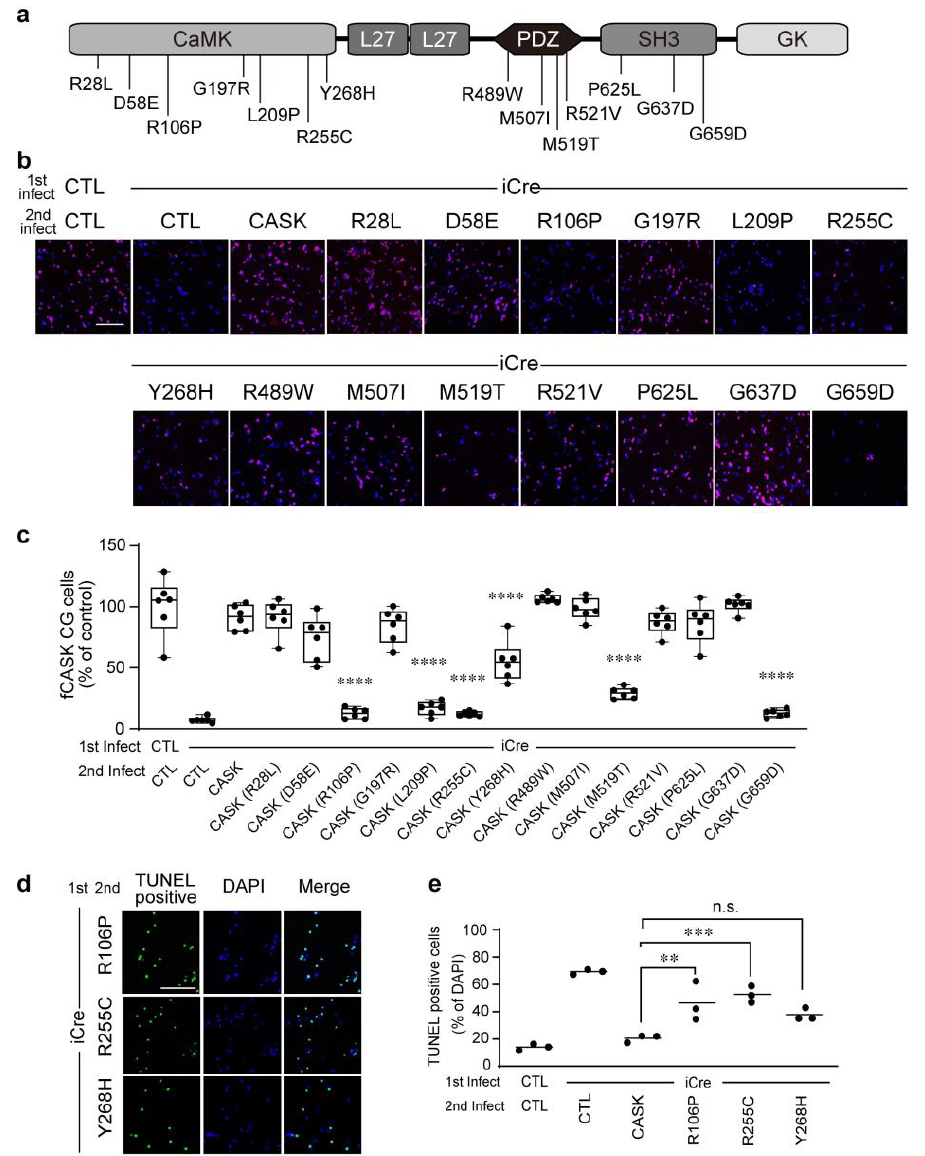
Figure 5. CASK missense mutations from human patients affect the survival of cultured CG cells. ( a ) Schematic diagram of CASK missense mutations identified from human patients. ( b ) Effects of CASK missense mutants on CASK KO CG cell survival. Cultured CG cells are infected with lentivirus-iCre (iCre) together with lentivirus-CASK (WT or mutants). Cells were stained with the antibody against NeuN (red) and DAPI (blue). Scale bars = 100 µ m. ( c ) Quantification of the number of NeuN-positive CG cells in ( b ). The values are averages of 3 points for each well and 6 wells for each sample. The horizontal line in each box indicates the median, the box shows the interquartile range (IQR), and the whiskers are 1.5× IQR. **** p < 0.0001; one-way ANOVA. ( d ) TUNEL analysis of CG cells. Cultured fCASK CG cells are infected with lentivirus-iCre (iCre) together with lentivirus-CASK (WT or missense mutants; R106P, R255C, and Y268H). The cells are stained using the In situ Cell Death Detection kit (green) and DAPI (blue). Scale bars = 100 μm. ( e ) Quantification of TUNEL-positive cells in ( e ). All values present the mean ± s.e.m. The values are averages of 3 points for each well and 3 wells for each sample. ** p < 0.01, *** p < 0.001; one-way ANOVA, n.s. = not significant.